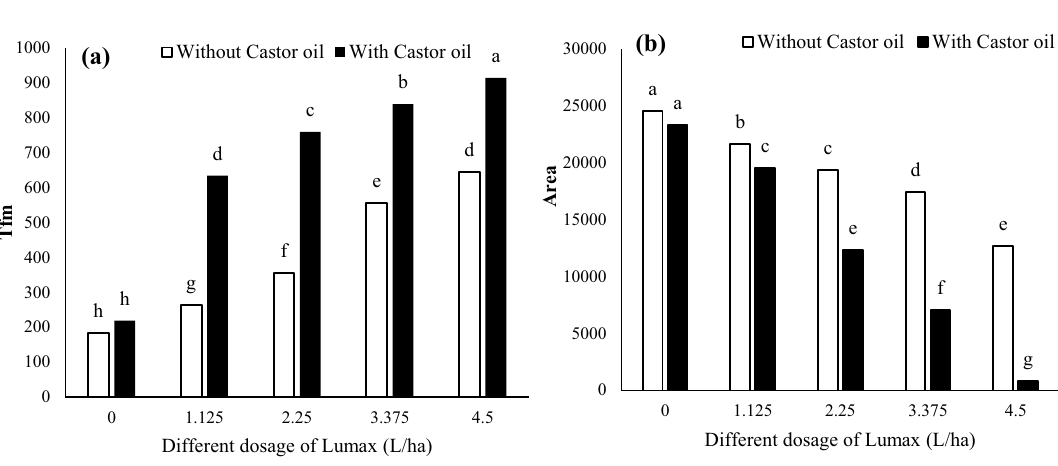
Figure 4. Changes in Tfm ( a ) and Area ( b ) of Solanum gigrum in response to different doses of Mesotrion + S-metolacholor + Terbuthylazine with and without Castor oil. Each value is the mean of four replicates. Different letters represent significant differences ( P <